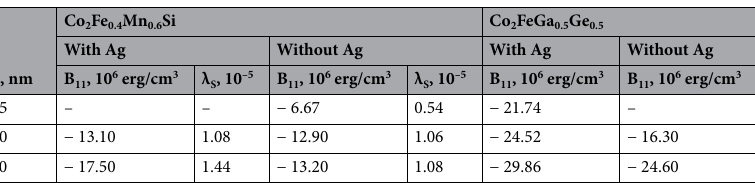
Table 1. The values of the magnetoelastic tensor components B 11 and corresponding saturation magnetostriction λ S obtained for CFMS and CFGG thin film samples. Elastic constants used for λ S calculation are taken from 87 .